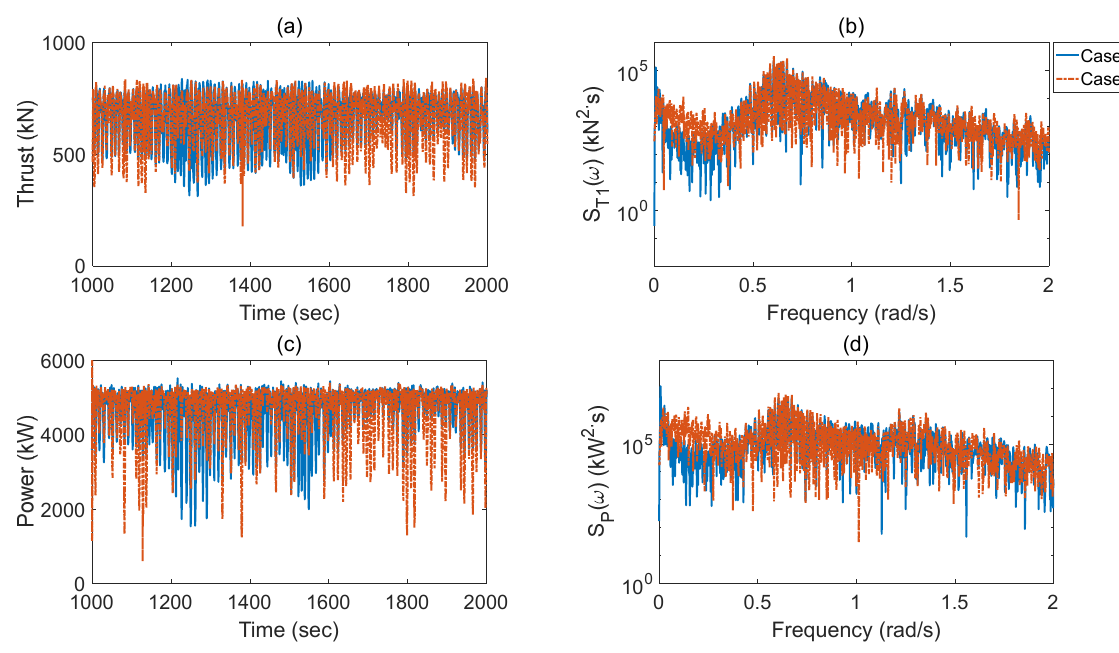
Figure 10. Time histories and power density spectra of thrust and power. ( a ) Time histories of thrust; ( b ) The power density spectra of thrust; ( c ) Time histories of power; ( d ) The power density spectra of power.